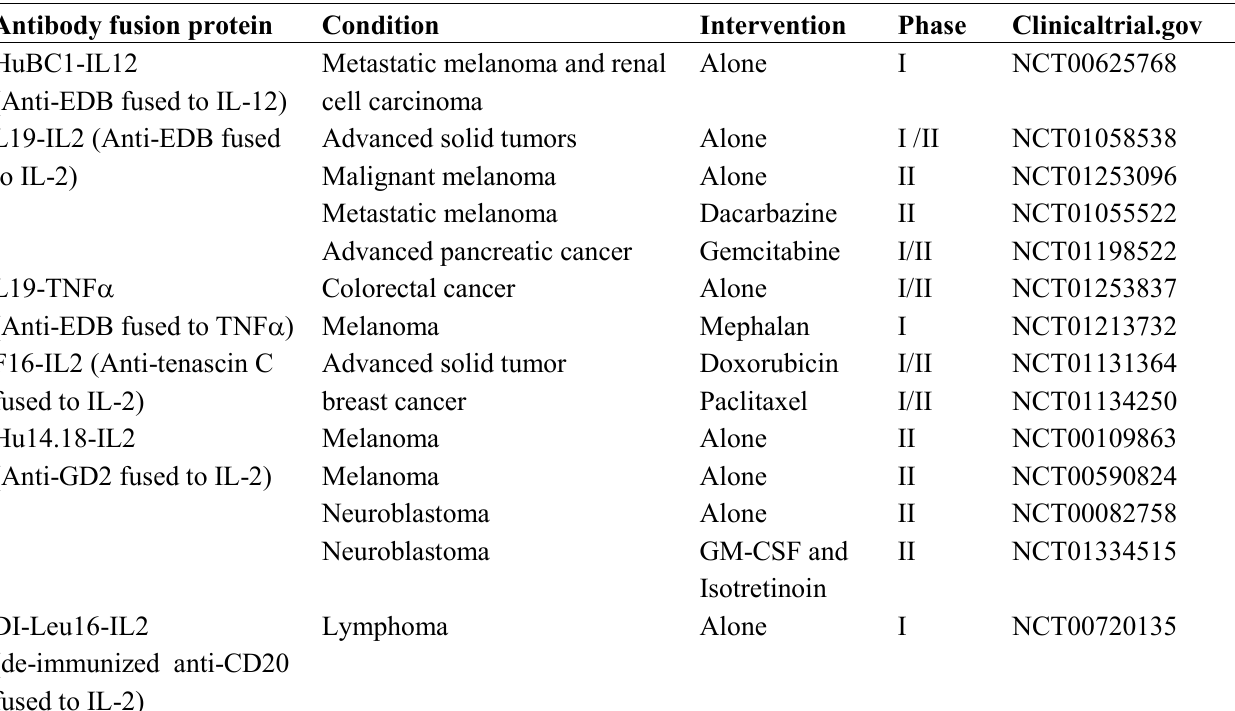
Table 1. Immunocytokines currently on clinical